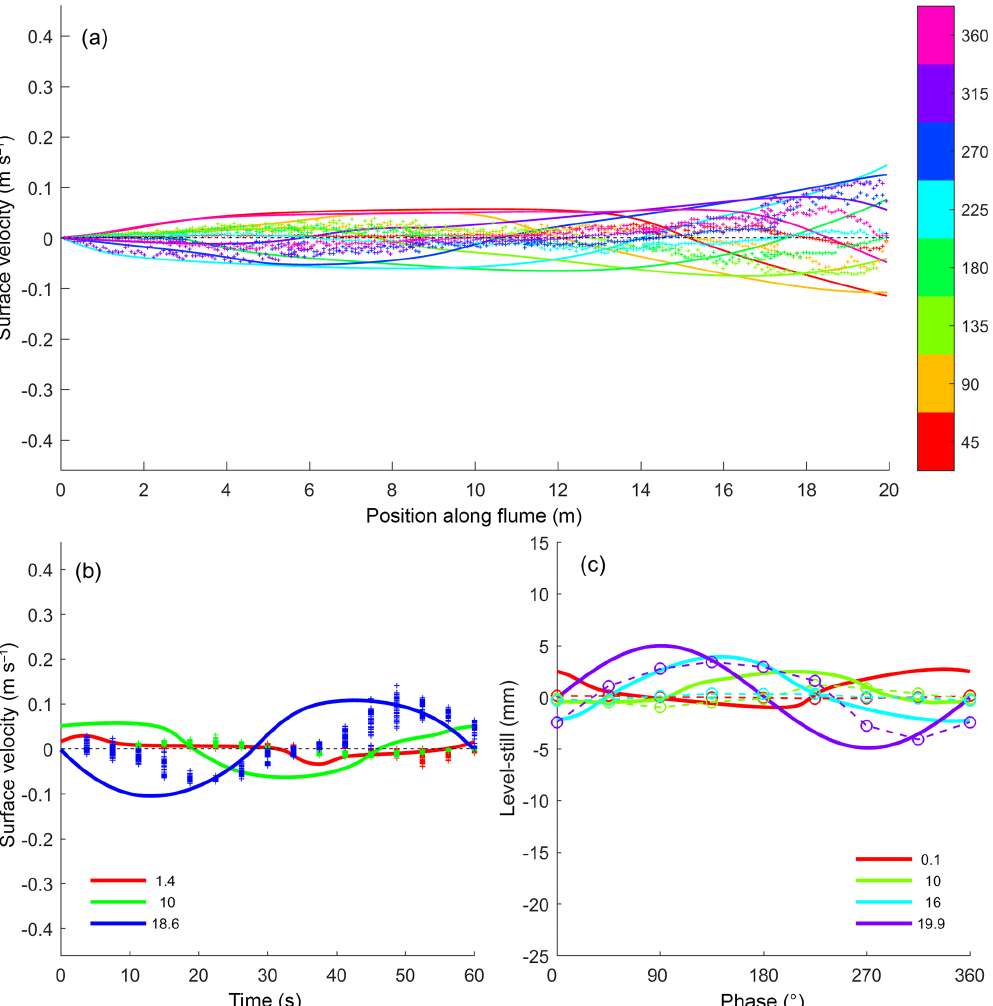
Figure 11. Flow data from PIV and modelled flow with 60s period sea level fluctuation at 0.01m of amplitude with the landward boundary closed. Positive flow velocity is in the ebb direction. (a) Flow velocity at the water surface along the flume for selected phases of the tidal cycle. (b) Flow velocity at the water surface in one tidal cycle for selected positions along the flume measured from x = 0m, indicated in the legend. (c) Water level as a function of phase in the tidal cycle for selected positions along the flume, indicated in the legend. Measured water levels have correct amplitude and phase but possibly erroneous vertical offsets. Data are plotted as symbols and model results are plotted as drawn